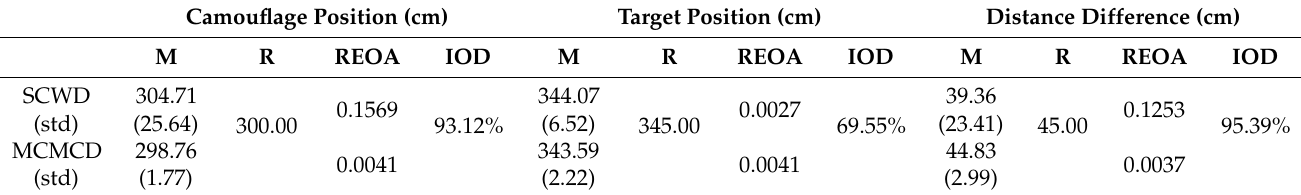
Table 5. Retrieval of distance information and evaluation using SCWD and MCMCD. Std, standard deviation.